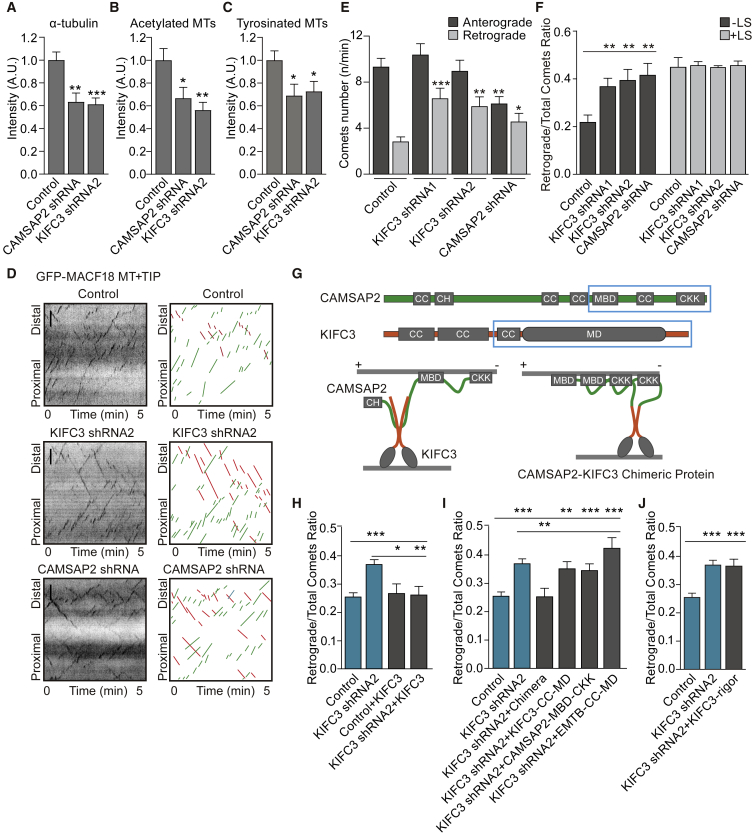
CAMSAP2 and KIFC3 Stabilize Minus-End-Out Microtubules(A–C) Quantification of α-tubulin (A), acetylated tubulin (B), and tyrosinated tubulin (C) levels in DIV11 neurons transfected with pSuper scrambled, CAMSAP2 shRNA, KIFC3 shRNA2, or KIFC3 overexpression (Figure S3A). (A) Control: N = 7, n = 58; CAMSAP2 shRNA: N = 7, n = 25; KIFC3 shRNA2: N = 7, n = 34. (B) Control: N = 3, n = 25; CAMSAP2 shRNA: N = 3, n = 12; KIFC3 shRNA2: N = 3, n = 15. (C) Control: N = 3, n = 25; CAMSAP2 shRNA: N = 3, n = 9; KIFC3 shRNA2: N = 3, n = 16. Error bars, SEM. Unpaired t test was performed, and columns were compared with corresponding control. ∗p < 0.05; ∗∗p < 0.01; ∗∗∗p < 0.001.(D) Original and illustrated kymographs of GFP-MACF18 traced with life-cell microscopy from control and KIFC3-shRNA2- and CAMSAP2-shRNA-transfected neurons. GFP-MACF18 was used to visualize microtubule plus-end tips. Anterograde comets are marked in green, and retrograde comets are marked in red. Scale bars, 3 μm.(E) Quantification of the number of comets moving retrogradely and anterogradely in dendrites of neurons described in (C). N = 2, control: n = 26, KIFC3 shRNA1: n = 20, KIFC3 shRNA2: n = 19, CAMSAP2 shRNA: n = 20. Error bars, SEM. ∗p < 0.05; ∗∗p < 0.01; ∗∗∗p < 0.001 (unpaired t test).(F) Quantification of the ratio of retrograde/total comets in dendrites of cells described in (D) with (black bars) and without (white bars) laser severing. No laser severing: N = 2, control: n = 26, KIFC3 shRNA1: n = 20, KIFC3 shRNA2: n = 19, CAMSAP2 shRNA: n = 20. Conditions with laser severing: control N = 1, n = 4; KIFC3 shRNA1 N = 1, n = 3; KIFC3 shRNA2 N = 1, n = 3; CAMSAP2 shRNA N = 2, n = 3. Error bars, SEM. ∗p < 0.05; ∗∗p < 0.01; ∗∗∗p < 0.001 (unpaired t test).(G) Schematic representation of the KIFC3, CAMSAP2, and CAMSAP2-KIFC3 chimeric protein. CH, calponin-homology domain; CKK, CKK domain; MBD, microtubule binding domain. The domains present in the chimeric protein are marked by blue rectangles. Green lines mark amino acids from CAMSAP2; orange lines mark amino acids from KIFC3. Microtubules with their orientations are marked in gray.(H–J) Quantification of retrograde/total comets ratio in dendrites of neurons transfected with pSuper-scrambled as control or KIFC3 shRNA2 together with different KIFC3 rescue constructs. KIFC3-rigor was validated by peroxisome distribution assay (Figures S3B and S3C). Control: N = 12, n = 78; KIFC3 shRNA2: N = 13, n = 85; control+KIFC3-FL: N = 3, n = 13; KIFC3 shRNA2+KIFC3-FL: N = 3, n = 21; KIFC3 shRNA2+Chimera: N = 3, n = 18; KIFC3 shRNA2+KIFC3-CC-MD: N = 3, n = 22; KIFC3 shRNA2+CAMSAP2-MBD-CKK: N = 4, n = 37; KIFC3 shRNA2+EMTB-MBD-CKK: N = 3, n = 15; KIFC3 shRNA2+KIFC3-rigor: N = 4, n = 32. Error bars, SEM. Columns were compared with control or KIFC3 shRNA2, respectively. ∗p < 0.05; ∗∗p < 0.01; ∗∗∗p < 0.001 (unpaired t test).